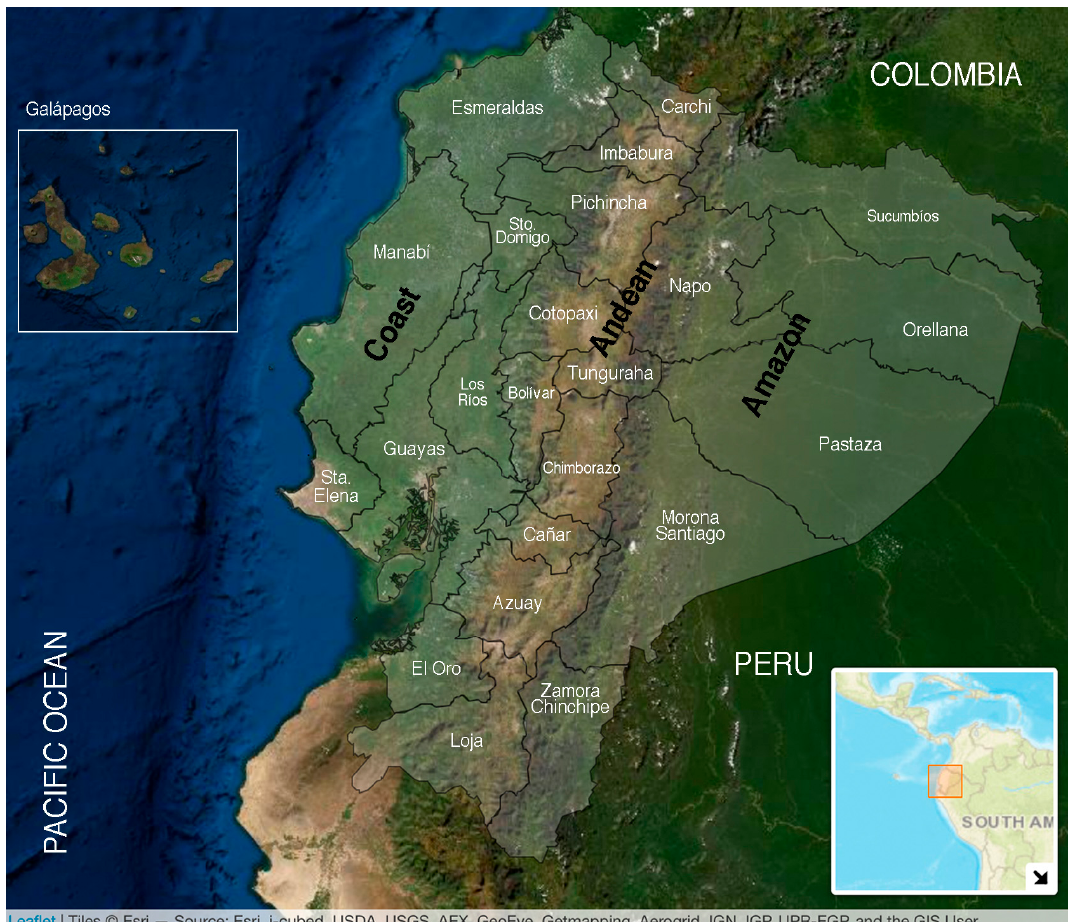
Figure 1. Map of Ecuador. The continental area includes a total of 276,841 km 2 and is divided into three ecoregions by the Andean Mountains: the Coast in the west, bordering the Pacific Ocean, the Andes in the middle, and the Amazon in the east bordering both Peru and Colombia. Ecuador is divided administratively into the 24 provinces signaled in white words. The Coast encompasses seven (Esmeraldas, Manabí, Santo Domingo de los Tsáchilas, Los Ríos, Guayas, Santa Elena, and El Oro); the Andes encompasses 10 provinces (Carchi, Pichincha, Tungurahua, Chimborazo, Cañar, Azuay, Loja, Imbabura, Bolívar, and Cotopaxi); and the Amazon encompasses six provinces (Su- cumbíos, Napo, Orellana, Pastaza, Morona Santiago, and Zamora Chinchipe). The Galápagos Is-